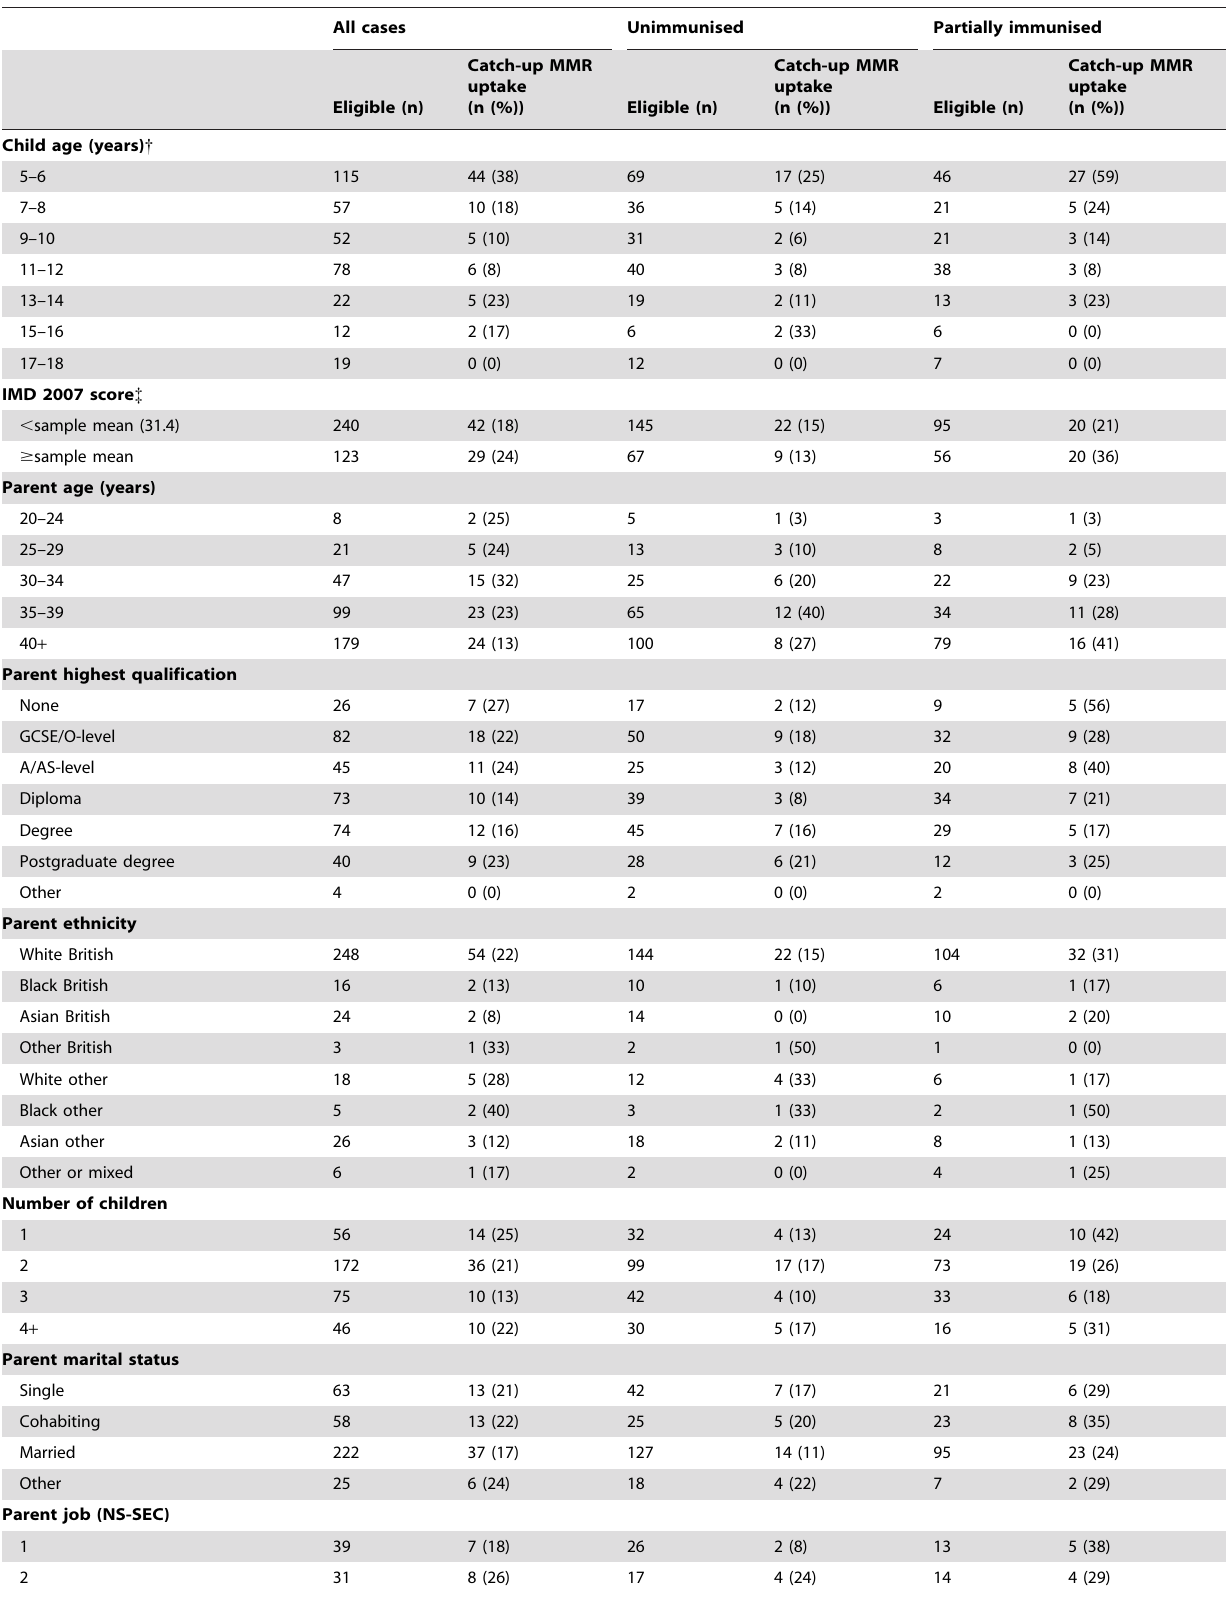
Table 2. Demographic characteristics by catch-up MMR